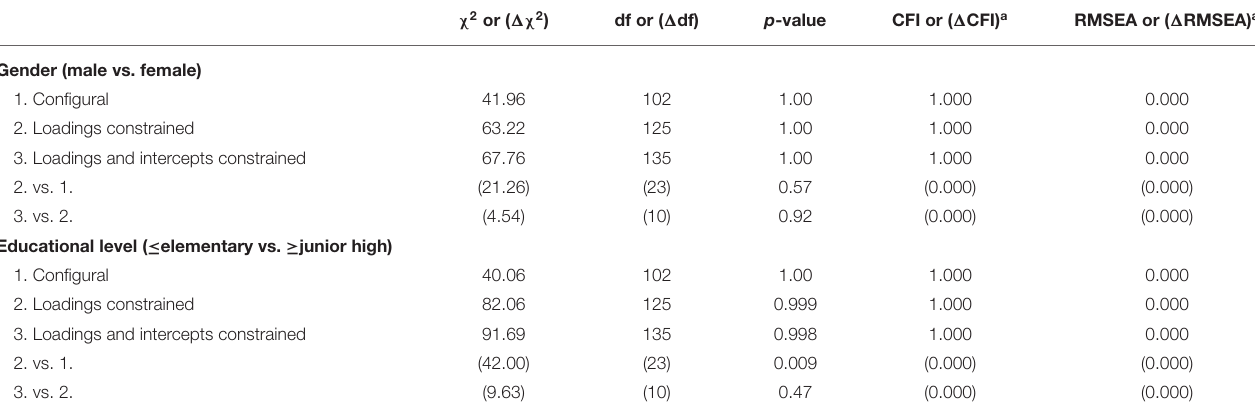
TABLE 4 | Measurement invariance of bifactor model across gender, educational level, and setting using sample aged over 70